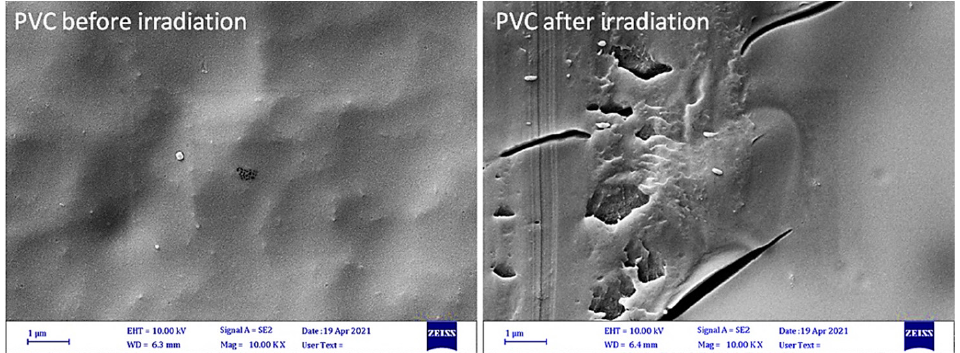
Figure 7. FESEM images of the blank PVC film before and after